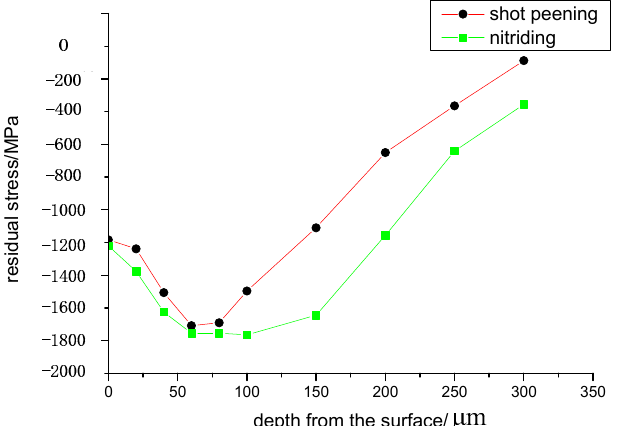
Figure 3. Residual stress distribution under different surface treatments.